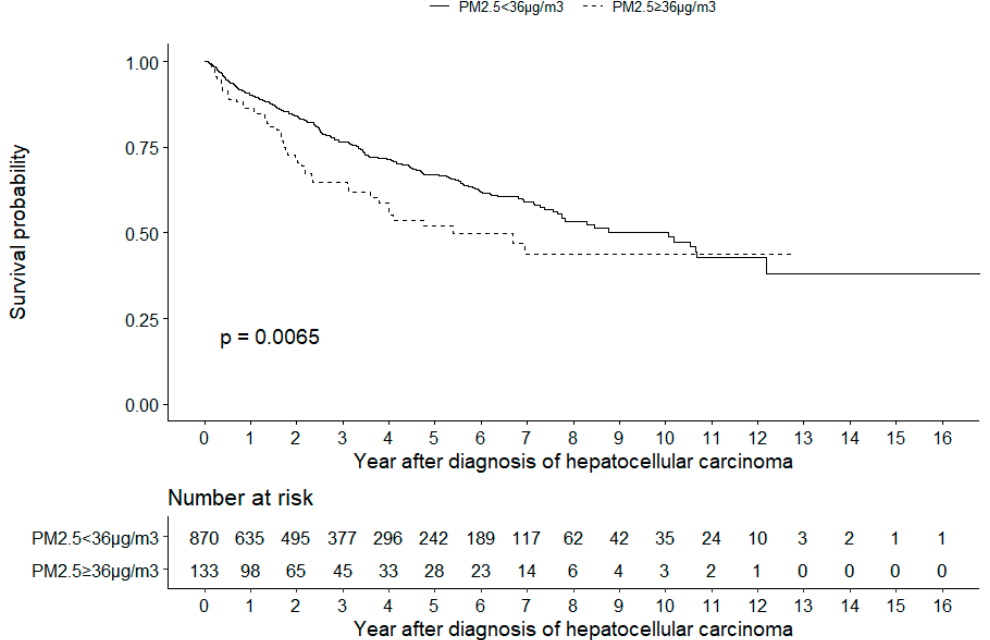
Figure 2. Kaplan–Meier analysis. The analysis revealed that patients with hepatocellular carcinoma living in environments with PM 2.5 concentrations of ≥ 36 µg/m³ had a lower cumulative survival than patients living in environments with PM 2.5 concentrations of <36 µg/m³ (log-rank test, P = 0.0065).